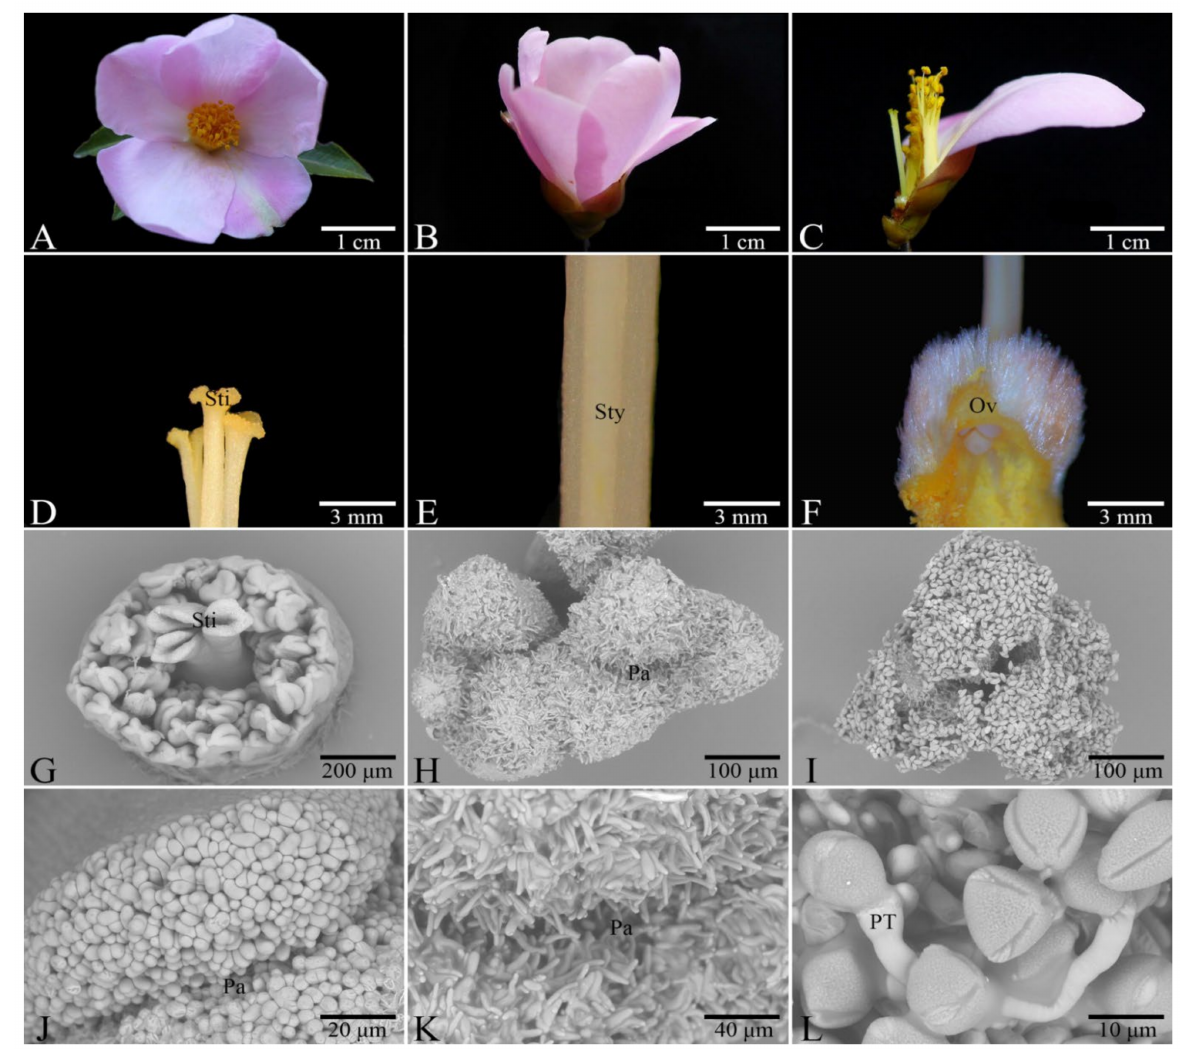
Figure 1. Characteristics of the flower organs of C. weiningensis . ( A – C ), flower morphology; ( D ) the stigma; ( E ) the style; ( F ) the ovary; ( G ) the pistil and stamen formation stage; ( H ) the style maturation period; ( I ) the style covered with pollen after pollination; ( J ) short mastoid cells of the stigma arranged regularly during pistil formation; ( K ) mastoid cells formed at the time of stigma maturation; ( L ) pollen grains grew into pollen tubes after pollination. Sti: stigma; Sty: style; Ov: ovary; Pa: papilla; PT: pollen